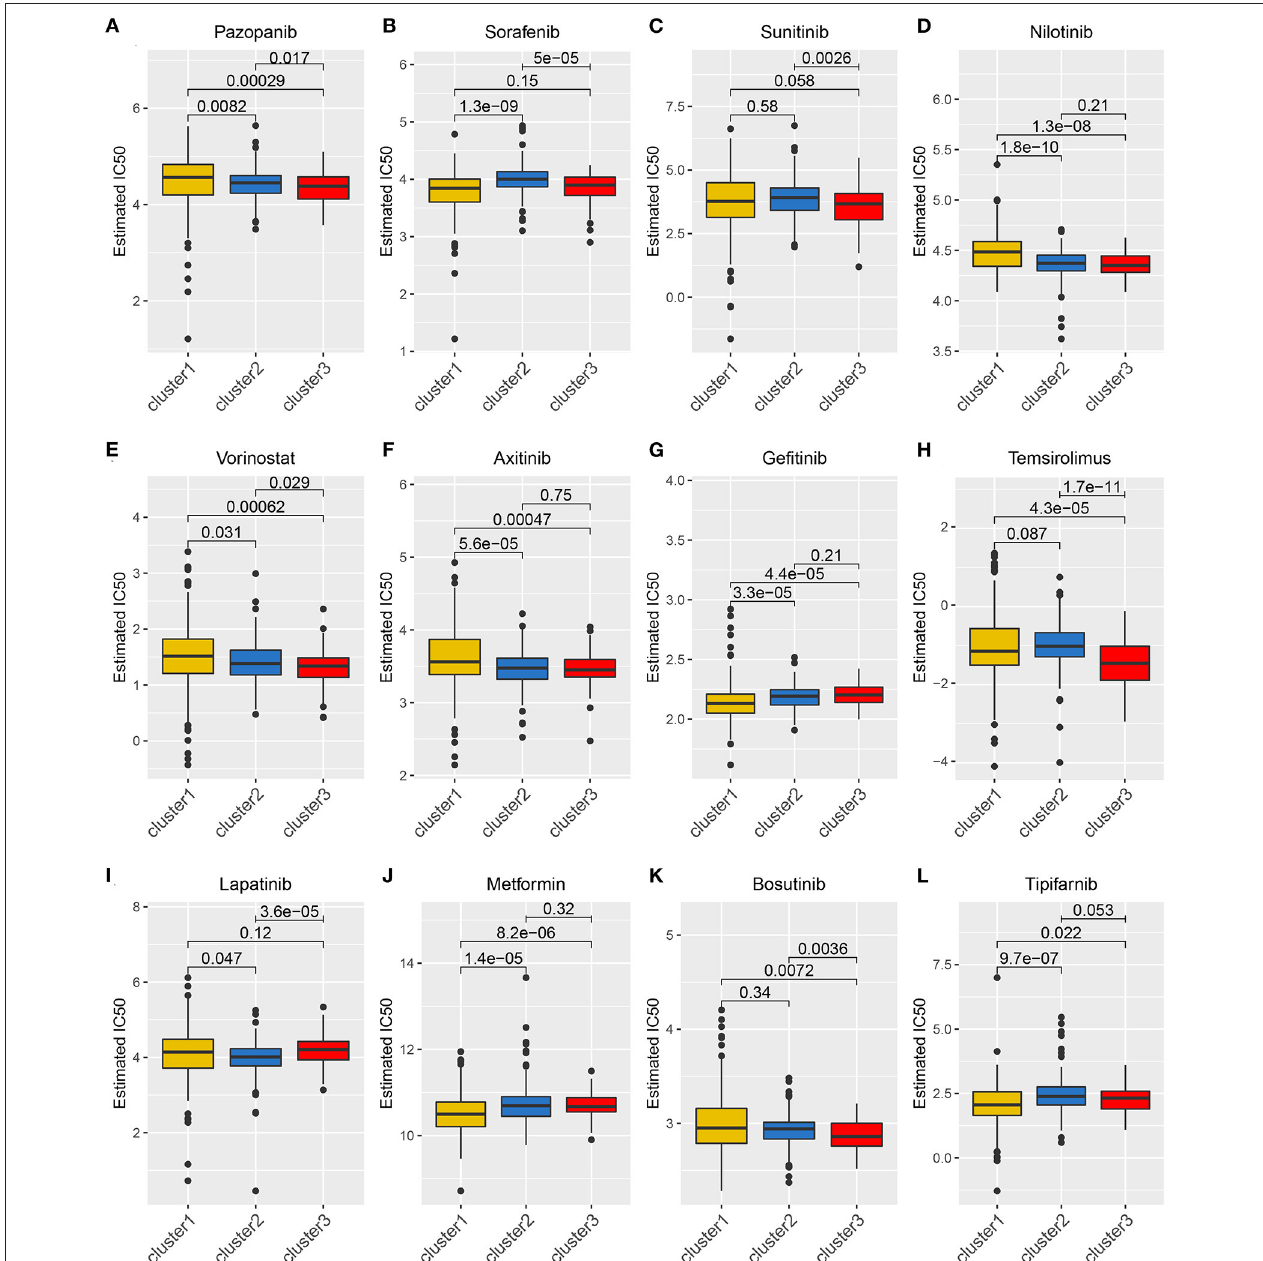
FIGURE 5 | The relationship between drug sensitivity and the angiogenesis clusters. The box plots of the estimated IC50 for 12 types of common chemotherapeutic agents are shown in (A–L) for cluster 1 (yellow), cluster 2 (blue), and cluster 3 (red). The 12 types of chemotherapeutic agents are pazopanib, sorafenib, sunitinib, nilotinib, vorinostat, axitinib, gefitinib, temsirolimus, lapatinib, metformin, bosutinib, and tipifarnib. The P -values are displayed above the clusters and the P < 0.05 were considered statistically significant. The box plots showed drug sensitivities among the angiogenesis clusters were different.